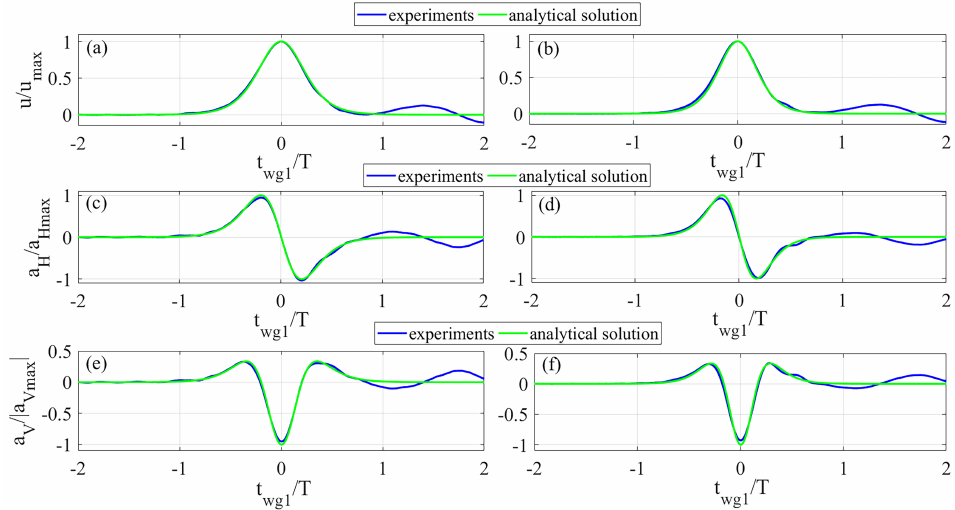
Figure 4. Comparison between experimental and analytical time series of kinematic field at wg1. ( a ) u (test no. 8); ( b ) u (test no. 18); ( c ) a H (test no. 8); ( d ) a H (test no. 18); ( e ) a V (test no. 8); ( f ) a V (test no.